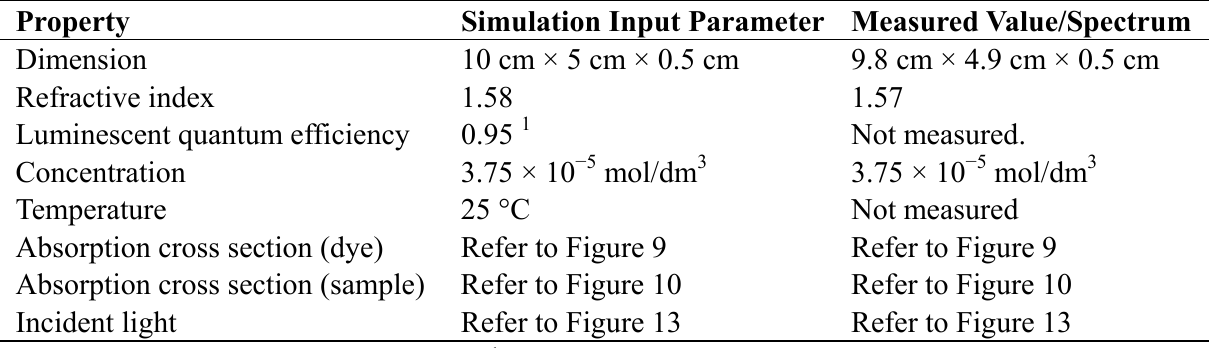
Table 1. Simulation input parameters versus the actual measured values.